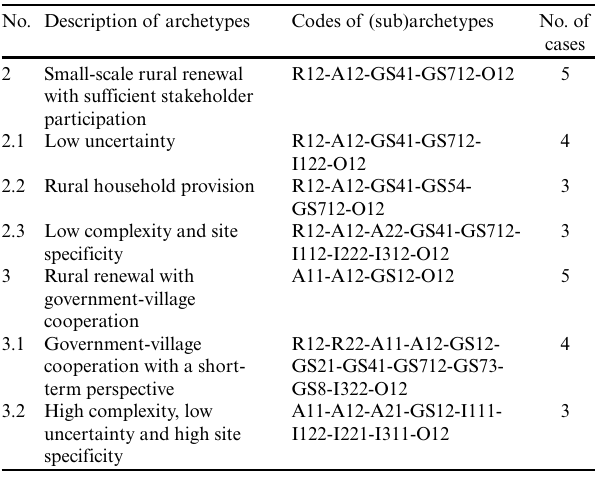
Table 3 . Archetypes for semisustainable rural